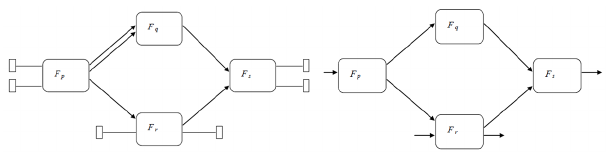
Figure 1. (Left) Example of a modular graph associated with four basic functions and five basic connections, three input points and three output points; (right) simplified description showing the acyclicity of the graph. Source: Nardi et al. (2009).